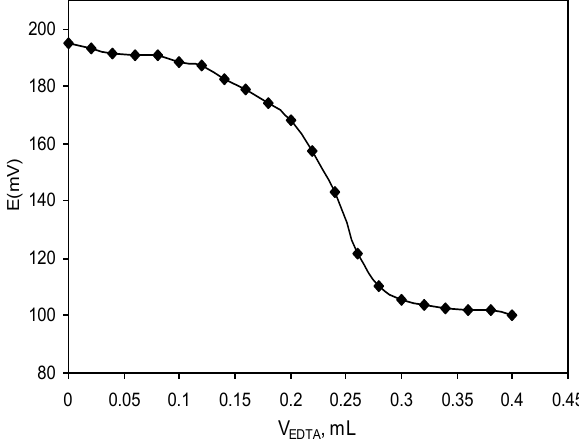
Figure 5. Potentiometric titration curve of 25.0 mL from a 1.0 × 10 -4 M Nd 3+ solution with 1.0 × 10 -2 M of